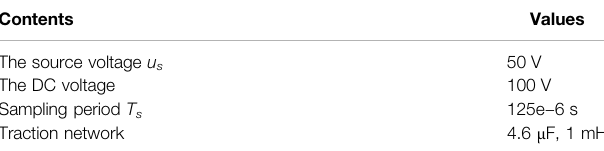
TABLE 4 | The parameters of the down-scale platform.